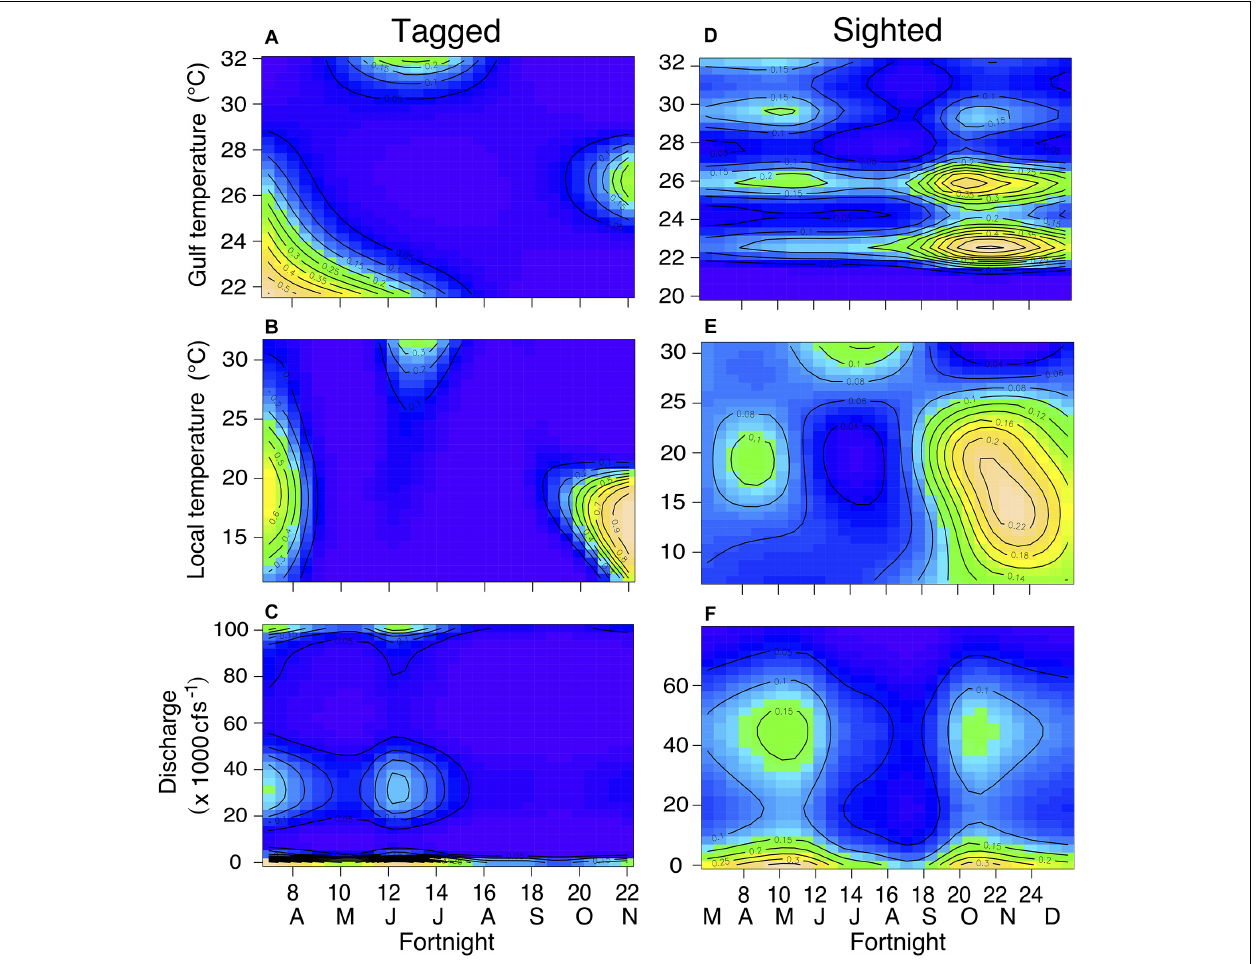
FIGURE 7 | Contour plots displaying interactions between fortnight period and nGoM water temperature (A,D) , local air temperature (B,E) , and freshwater discharge (C,F) for tagged (left column) and sighted (right column) individuals in the 130 and 300 m ship channels. Cooler colors (e.g., blue, green) indicate lower probabilities while warmer colors (yellow, tan) indicate higher probabilities. Contour lines represent